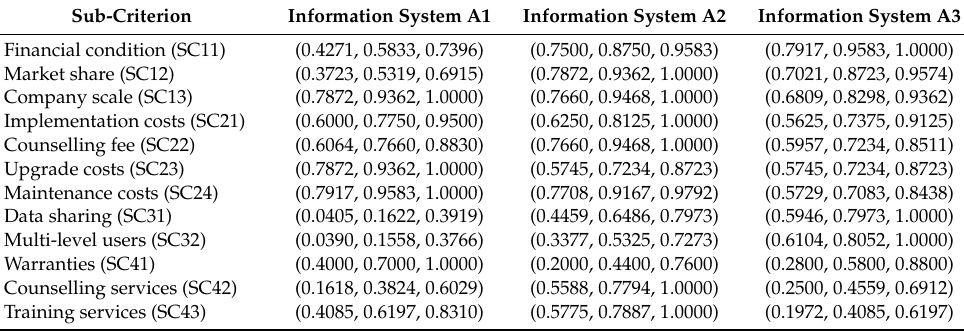
Table 10. Normalized fuzzy decision matrix (cid:101)